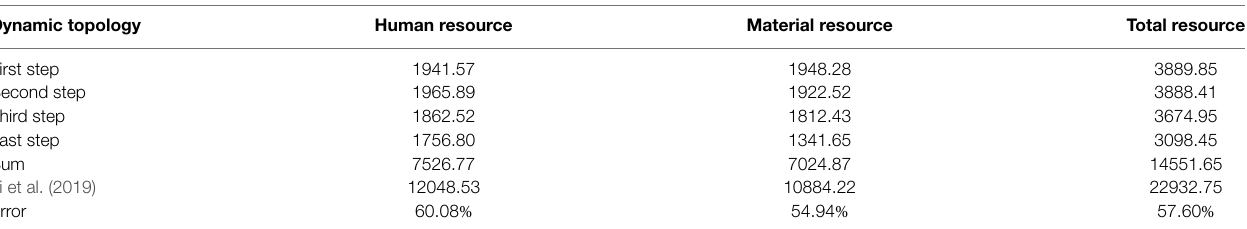
TABLE 4 | Resilient resources of dynamic resilient strategy and (Li et al., 2019) under hybrid